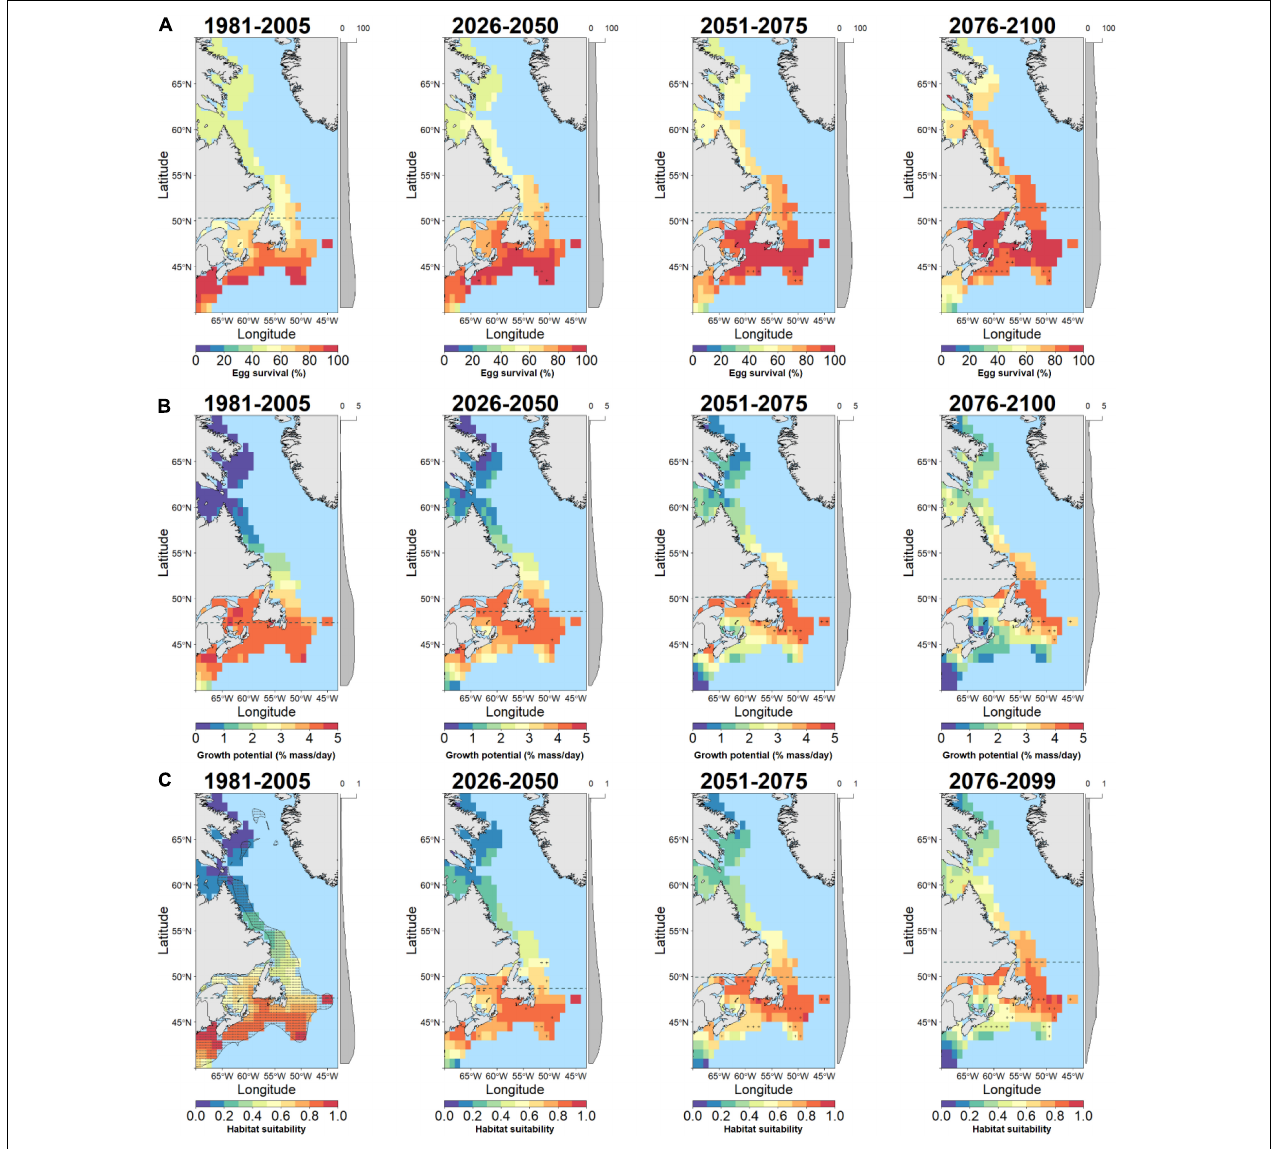
FIGURE 3 | Baseline and future projections of habitat suitability for Atlantic cod ( G. morhua ) based on temperature-dependent egg survival (A) , temperature-dependent juvenile growth potential (B) , and geometric means of combined egg and juvenile habitat suitability (C) . Cells with high uncertainty (small change relative to spread across models) are indicated by a (+) symbol. The latitudinal component of the distribution centroid is denoted by a dashed gray line across each plot. Marginal plots along the y -axis show the mean cell values across latitude. The current distribution of G. morhua is shown on the baseline habitat suitability (stippled area; bottom left